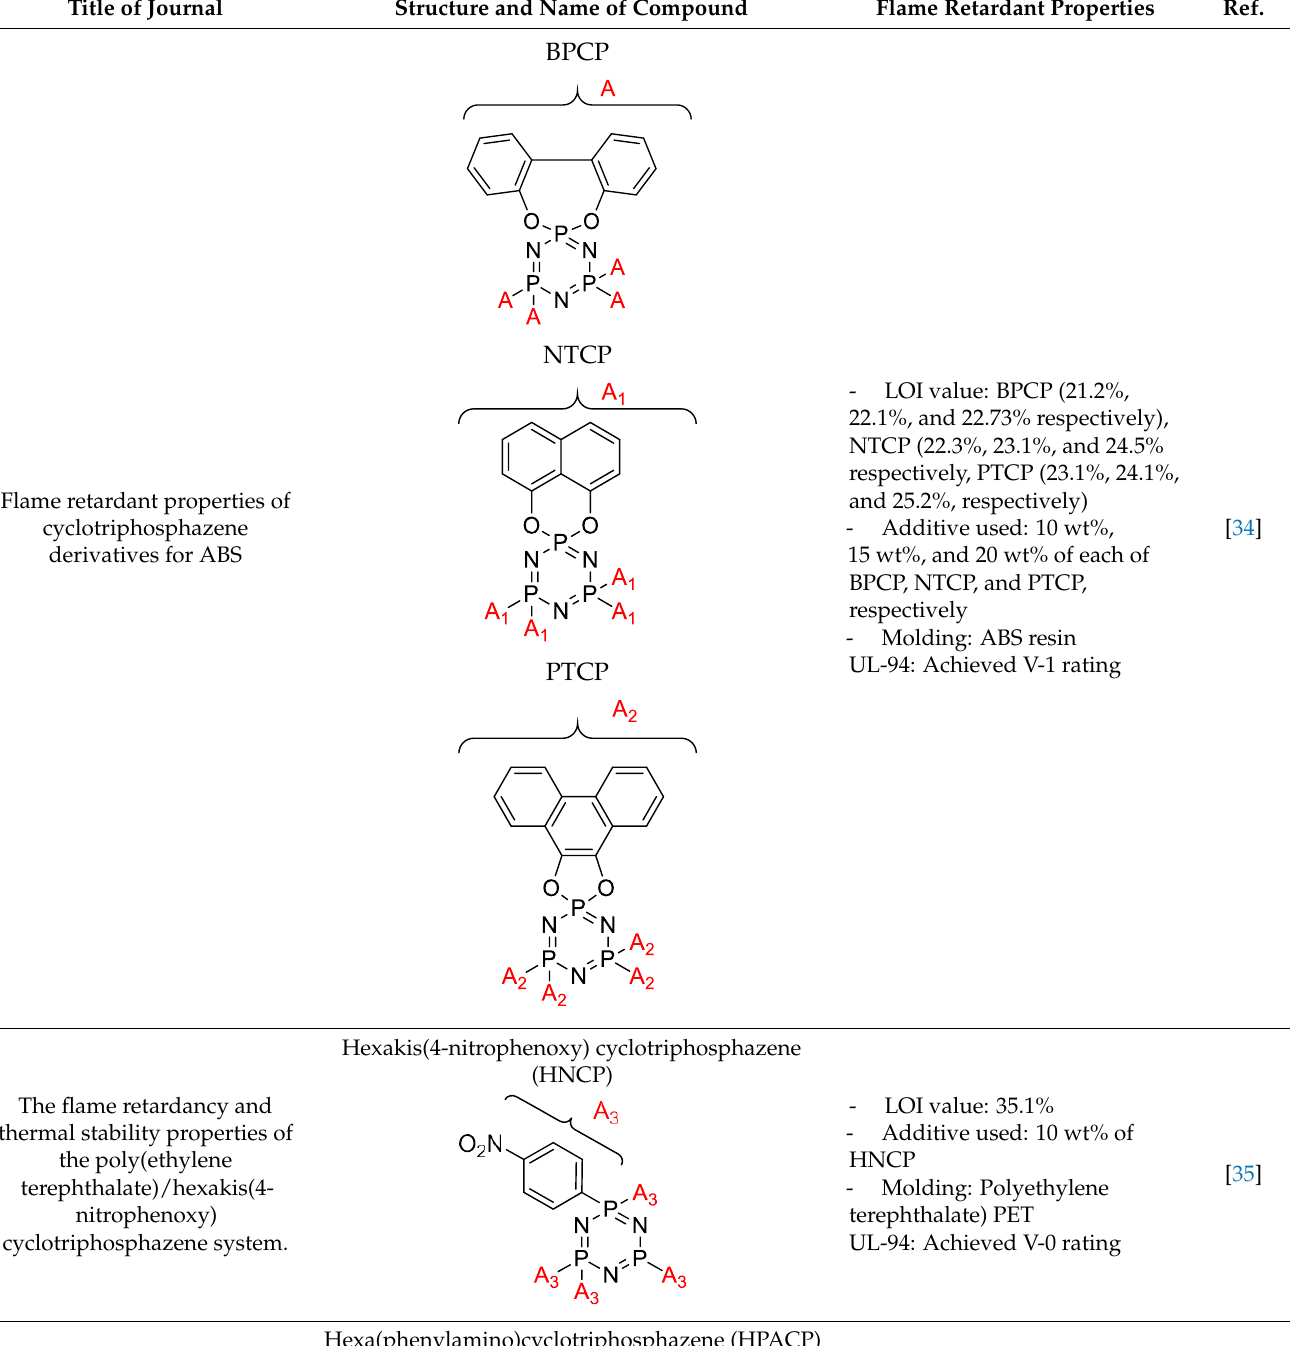
Table 1. Summary of the synthesis of hexasubstituted cyclotriphosphazene and their flame retardancy properties.